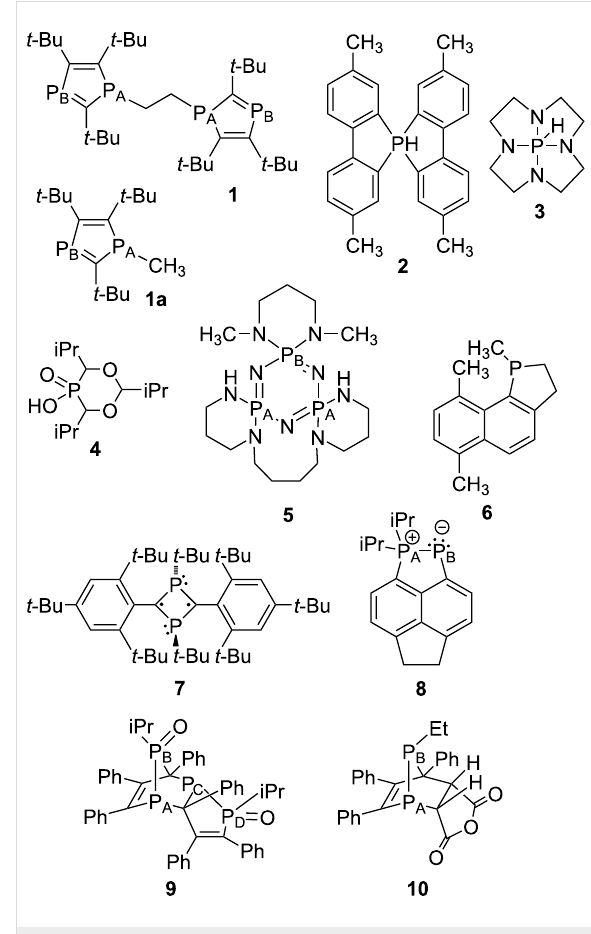
Figure 4: “Large” compounds selected for 31 P NMR calculation by Latypov